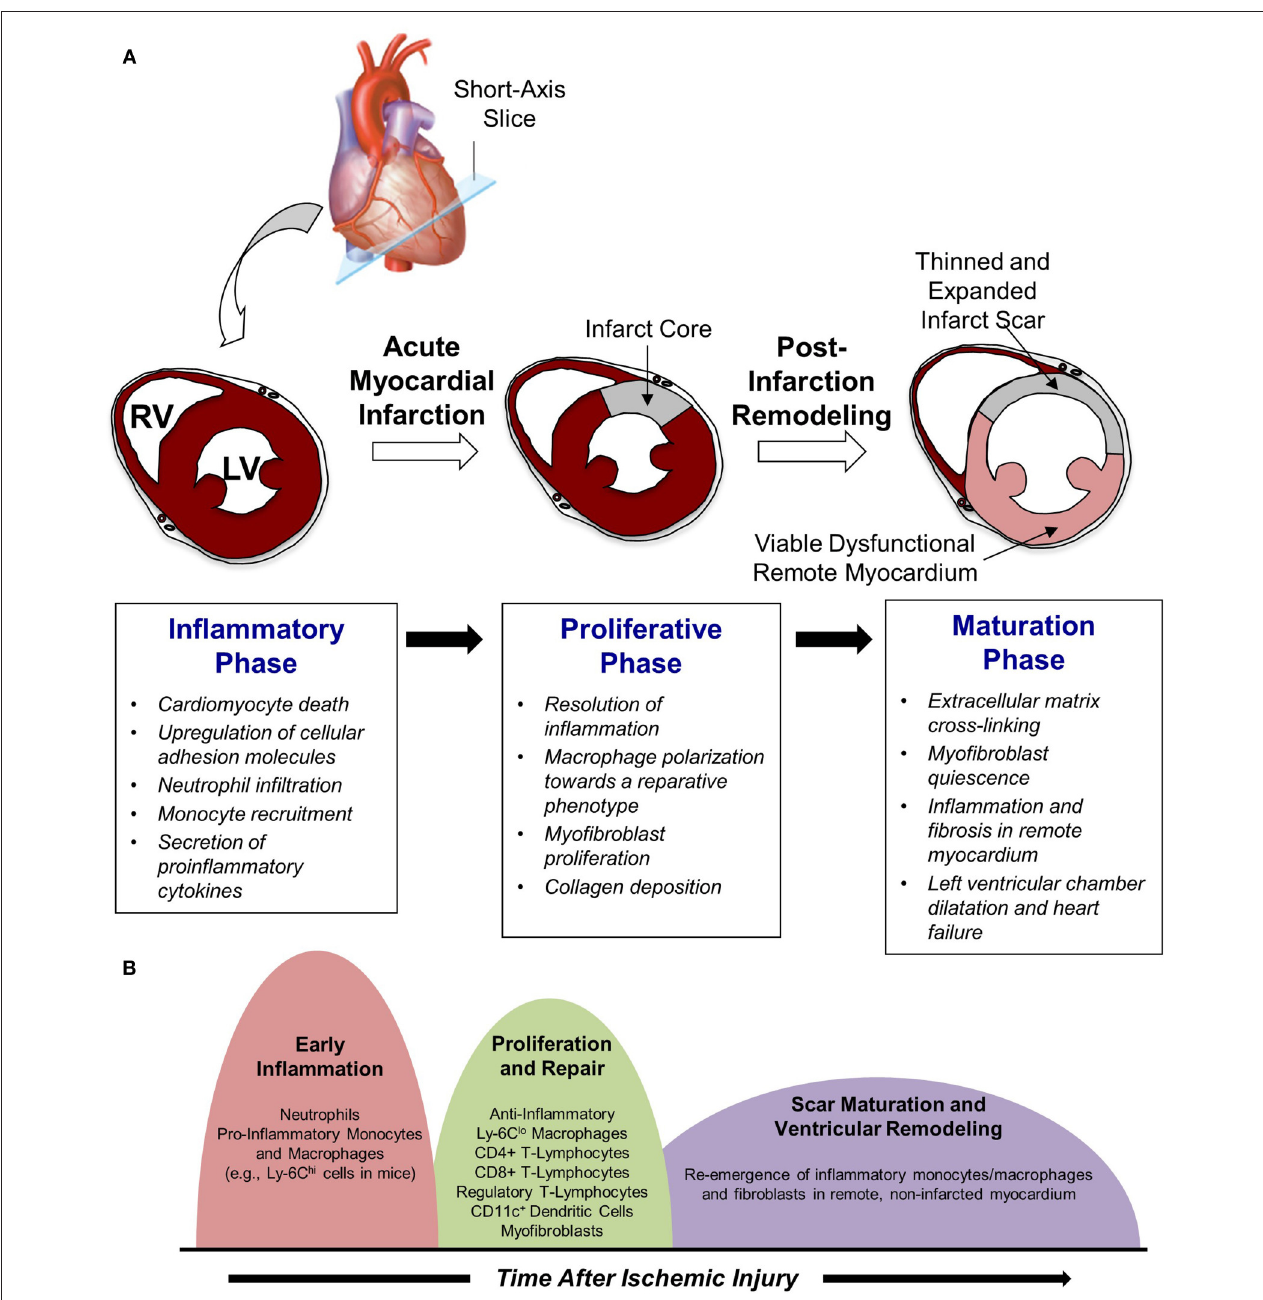
FIGURE 1 | Cardiac repair after myocardial infarction. (A) The three phases of repair. (B) Temporal changes in leukocyte populations during repair phase.